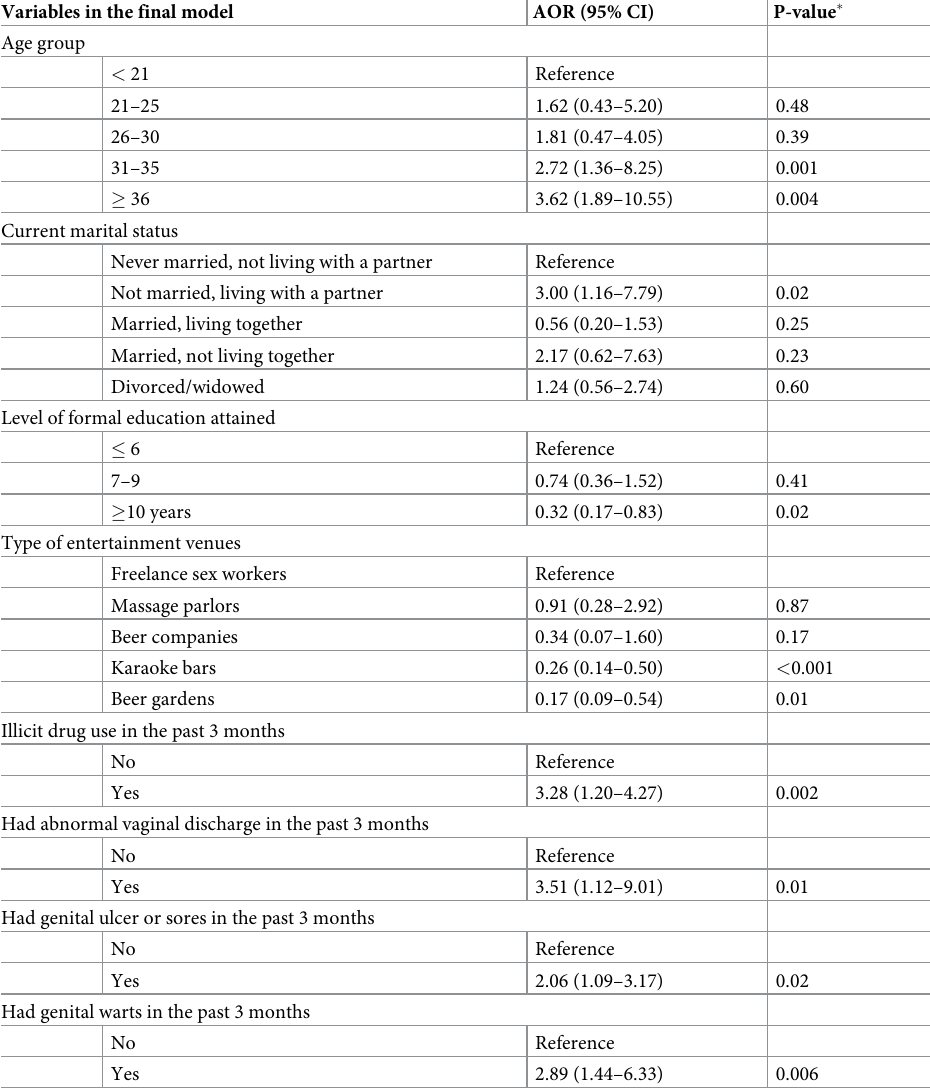
Table 3. Factors associated with HIV infection among female entertainment workers ( n =